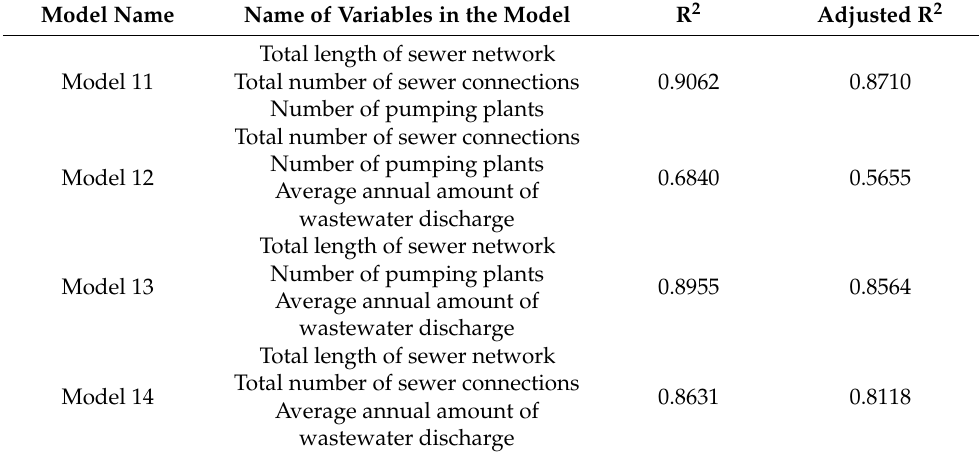
Table 9. Proposal for variables of the maintenance cost estimation models with three